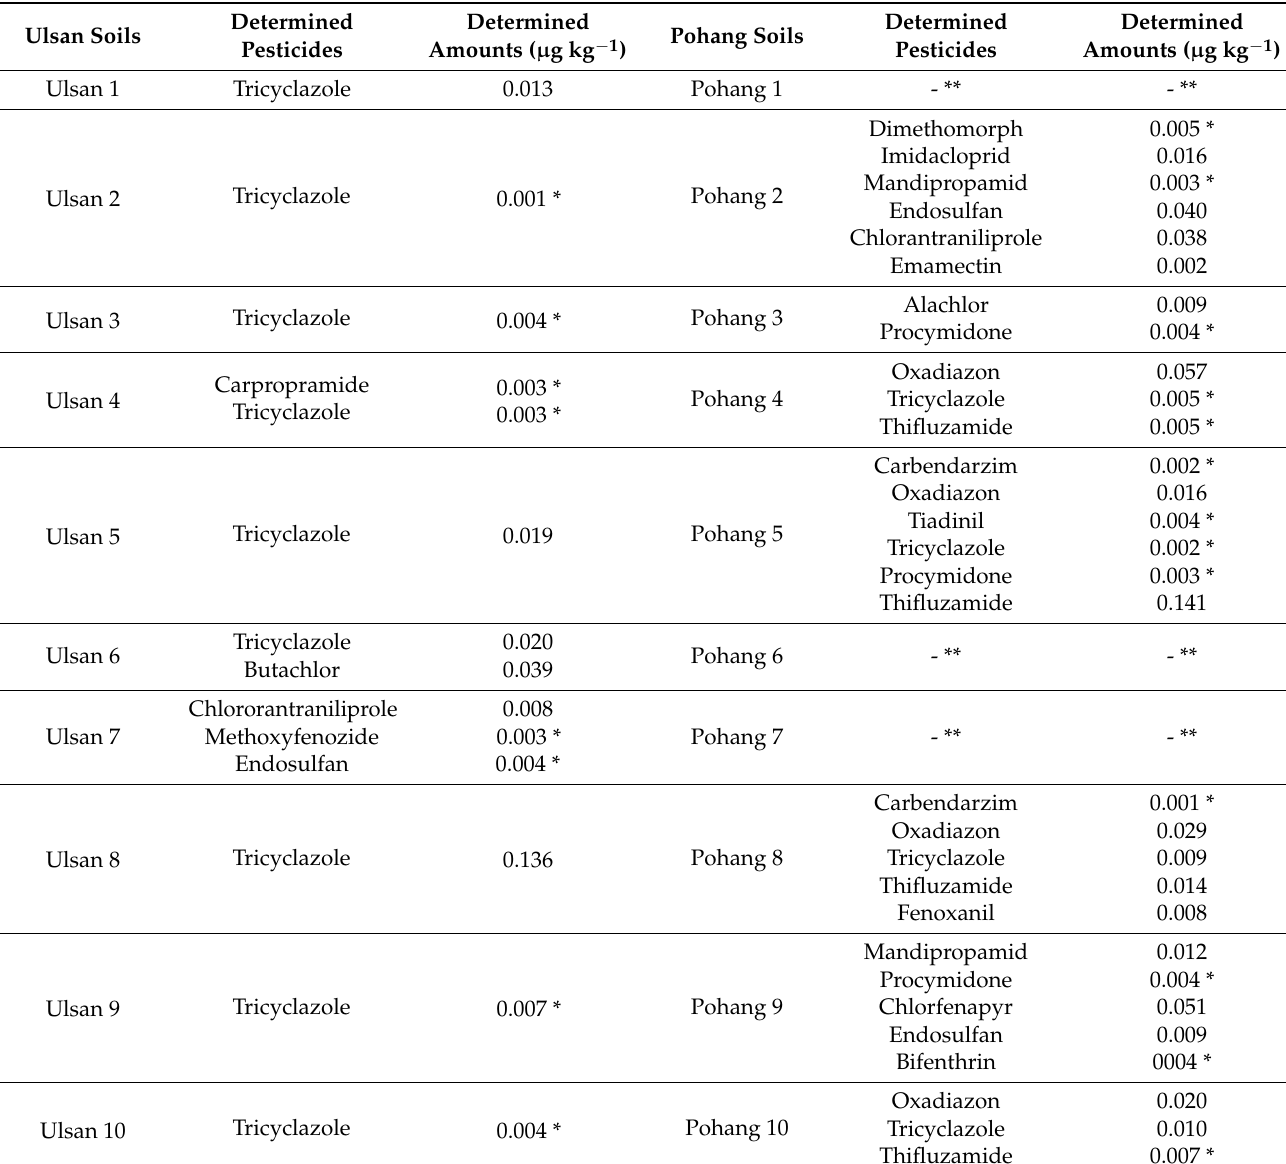
Table 7. Residual amounts of pesticides in soils at 20 sites in Ulsan city and 20 sites in Pohang city as analyzed by GC–MS/MS and LC–MS/MS. Determined Determined Determined Determined Pohang Soils Pesticides Amounts ( µ g kg − 1 Pesticides Amounts ( µ g kg − 1 )